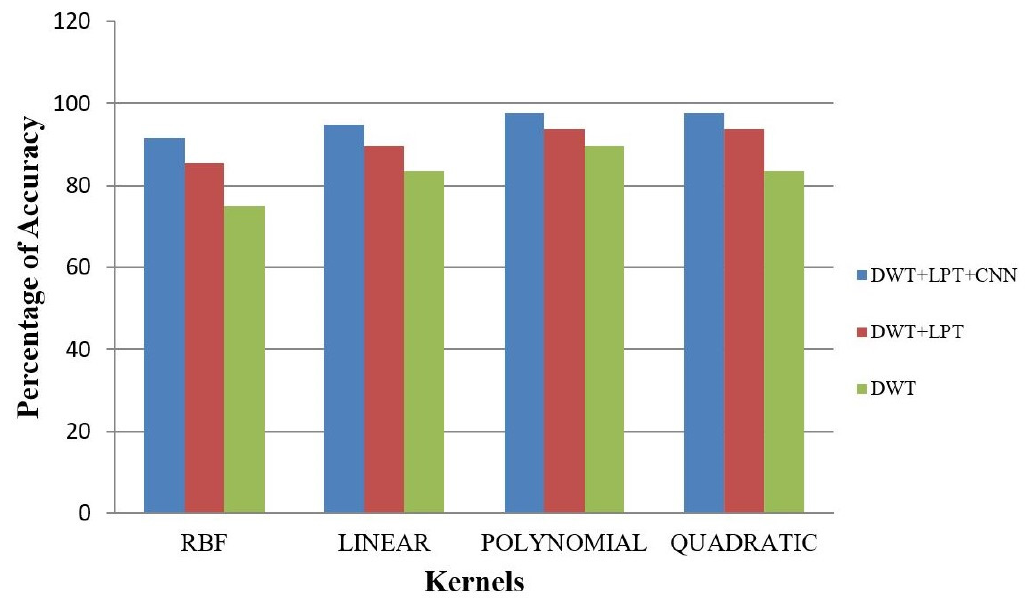
Figure 12. Average Accuracy for Tumor Detection of T-1 weighted images.